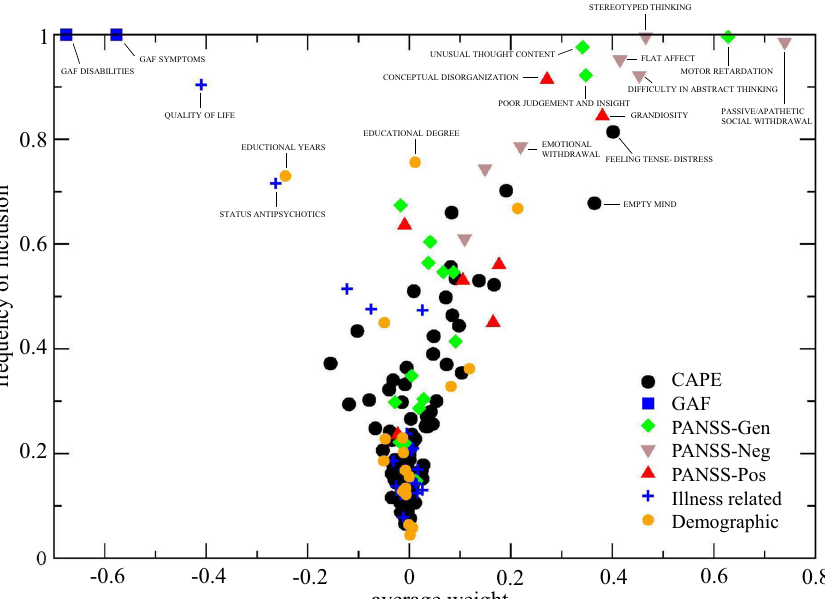
Fig. 1 Frequency of inclusion and weight of features. Frequency of inclusion of a feature against its (average) weight in the model; shown for prediction of global assessment of functioning (GAF) outcome at T 3 , containing Positive and Negative Syndrome Scale — general, negative, and positive subscale (PANSS — Gen, Neg, and Pos), Demographic, Illness-related and lifetime psychotic experiences (CAPE) related features. A positive weight re fl ects that scoring higher on this feature contributes to being classi fi ed as ‘ poor outcome ’ . For features with negative weights the opposite